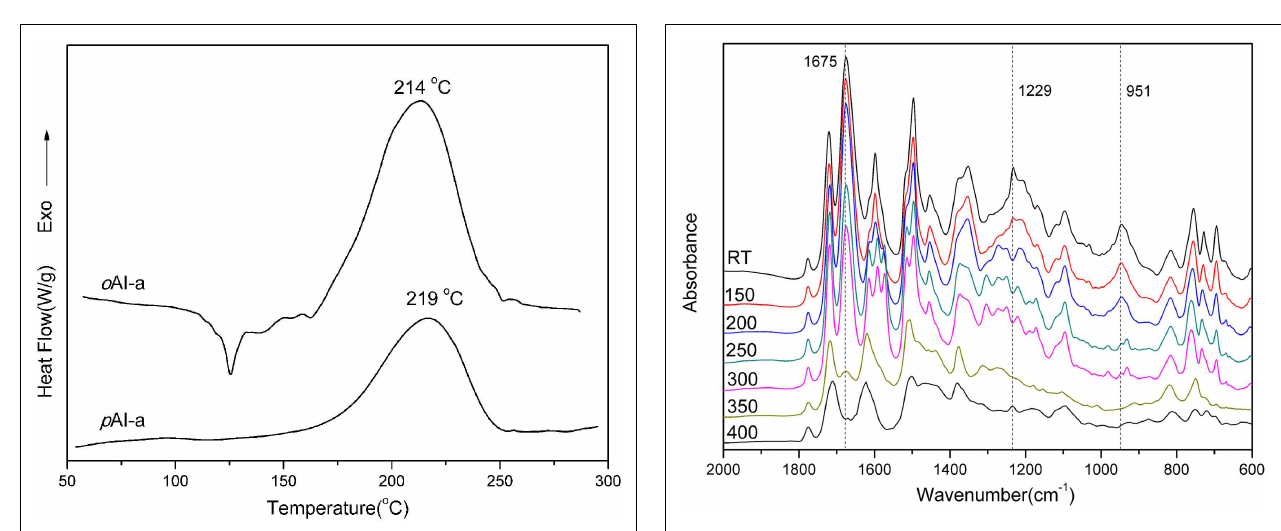
FIGURE 6 | Fourier transform infrared spectra of p AI-a after various thermal treatment .